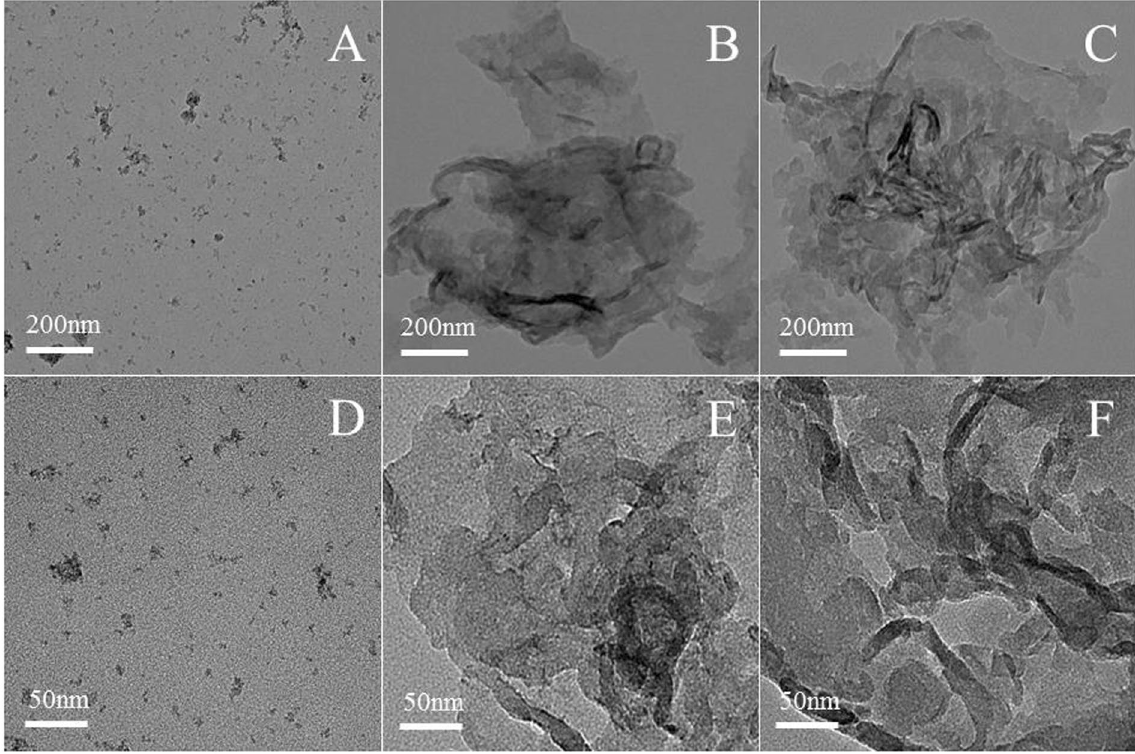
Figure 7. TEM images of ( A ) and ( D ) a-FeOOH, ( B ) and ( E ) a-FeOOH/CNNS-800 composite and ( C ) and ( F ) CNNS.